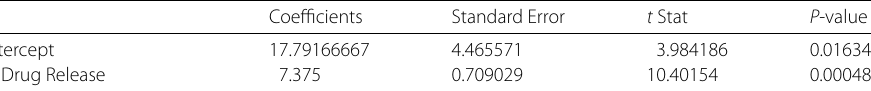
Table 3 Statistics of Nitrofurantoin MR